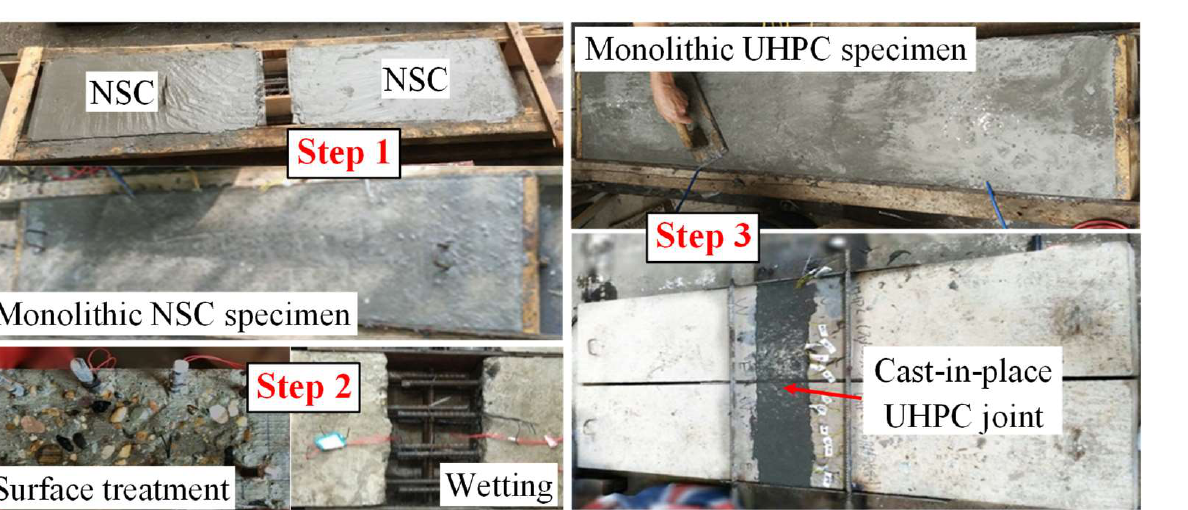
Figure 2. Fabrication of test specimens.